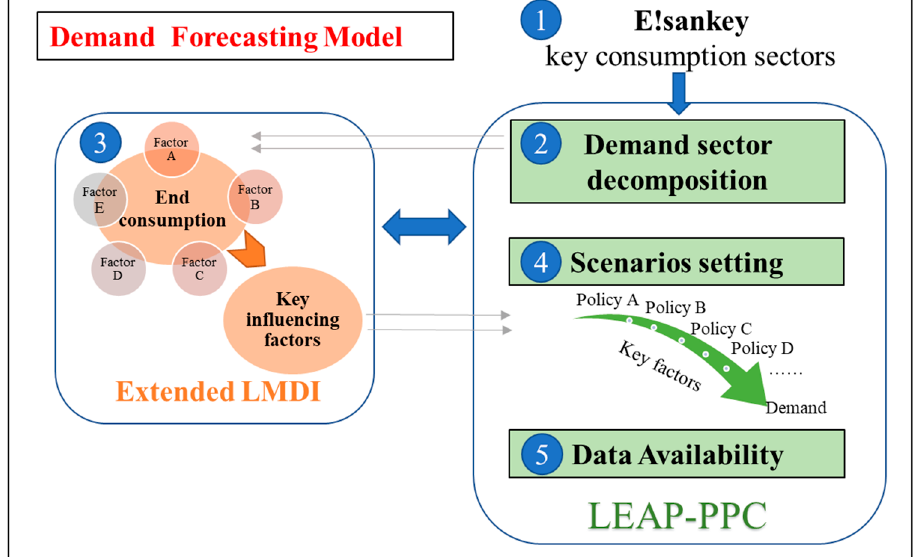
Figure 3. Framework of